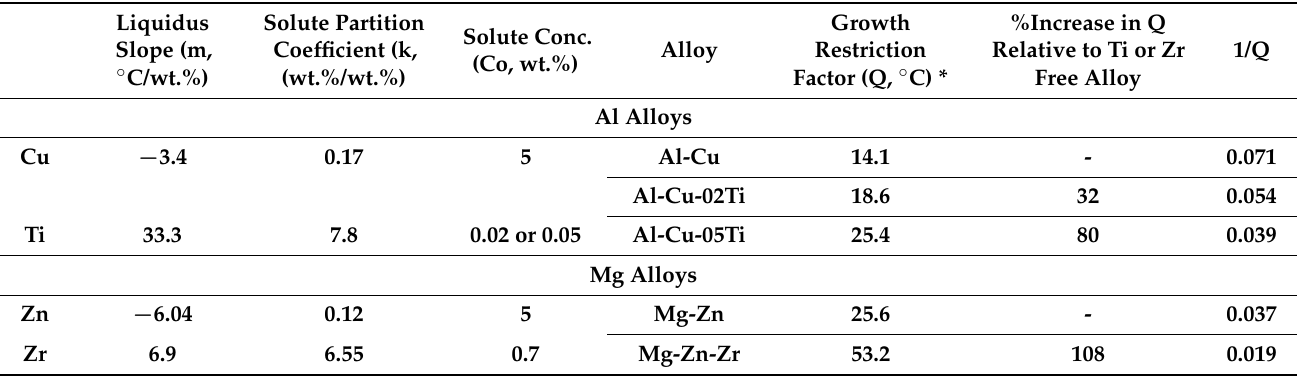
Table 3. Equilibrium Phase Diagram Properties of Solute in Al and Mg [73,74] with Calculated Q Values for Examined Al and Mg